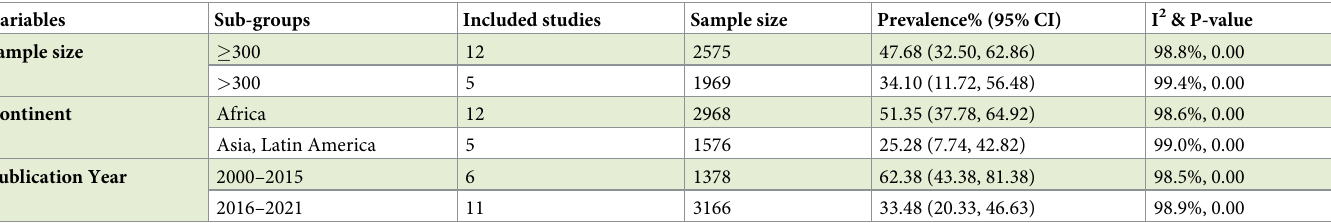
Table 2. The pooled prevalence of intestinal parasitic infection among street dwellers and prison inmates based on subgroup analysis. Variables